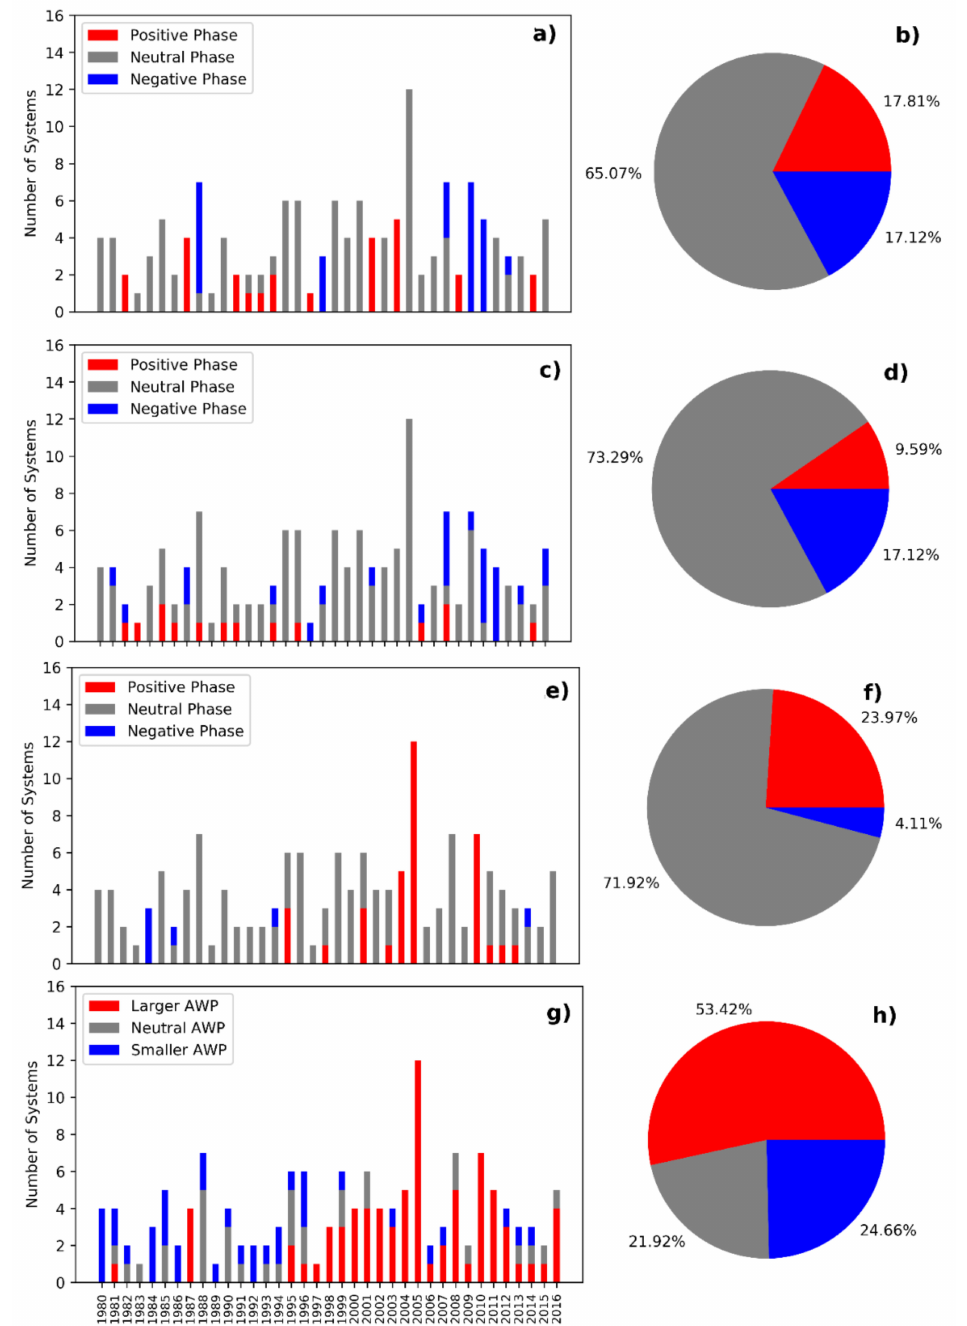
Figure 6. Left column: Number of TC systems during the di ff erent phases of ENSO ( a ), NAO ( c ), AMM ( e ) and AWP ( g ). Right column: Percentage of TCs during each phase of ENSO ( b ), NAO ( d ), AMM ( f ) and AWP ( h ). Period: